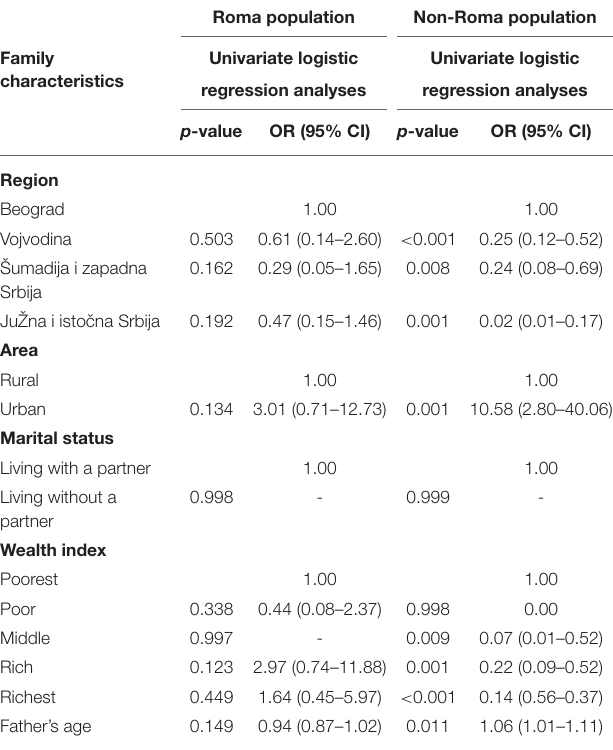
TABLE 5 | The associations between infants’ characteristics and the practice of exclusive breastfeeding—Univariate logistic regression. Roma